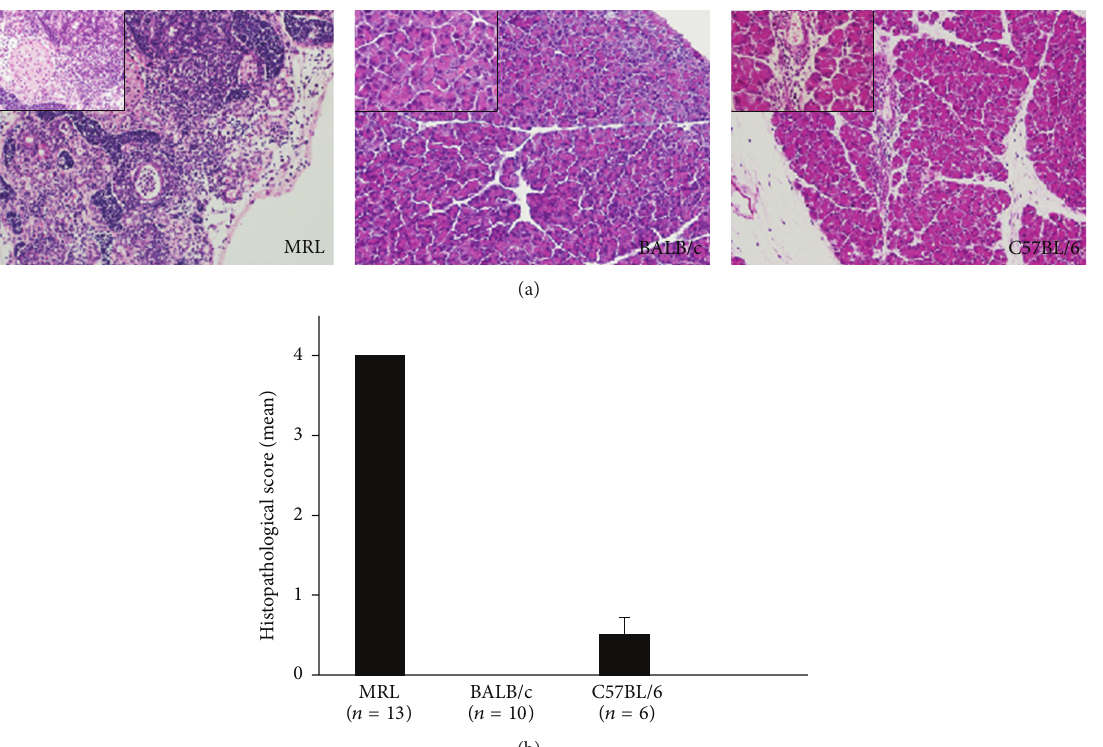
Figure 4: Representative H&E stained histological pancreatic sections of the pancreases (a) and histopathological pancreas scores (b) in poly I:C-treated MRL/Mp mice at the age of 18–20 weeks, poly I:C-treated BALB/c mice at the age of 18 weeks, and poly I:C-treated C57BL/6 mice at the age of 18 weeks. In MRL/Mp mice, representative pancreatic tissue showed almost all pancreatic tissue, except pancreatic islets, destroyed or replaced with fibrosis or adipose tissue (grade 4). In BALB/c mice, there was no significant change (grade 0). In C57BL/6 mice, pancreatic tissue showed mononuclear cell aggregation and infiltration within the interstitium without any parenchymal destruction (grade 1). × 100 magnification (large panel), × 400(inset). Data are expressed as mean ±